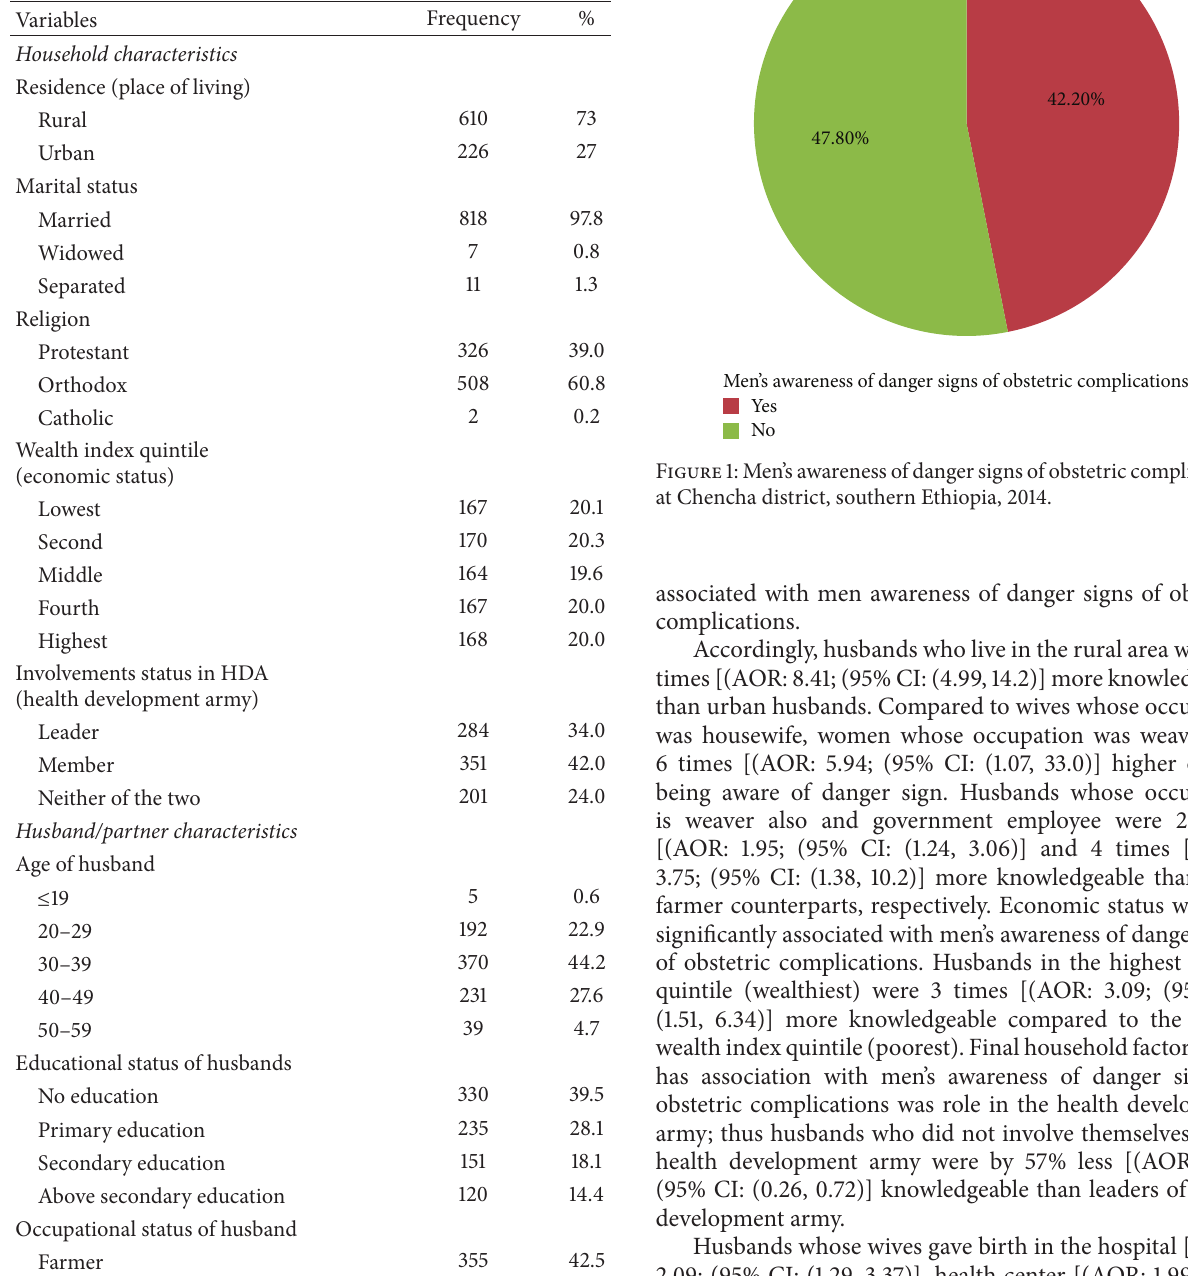
Table 1: Sociodemographic and socioeconomic characteristics of household, husband, and wives at Chencha district, southern Ethiopia, 2014.